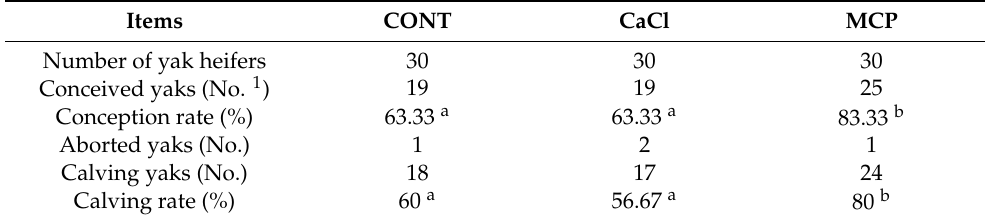
Table 4. Effects of calcium (Ca) and phosphorus (P) supplementation on reproductivity of yak